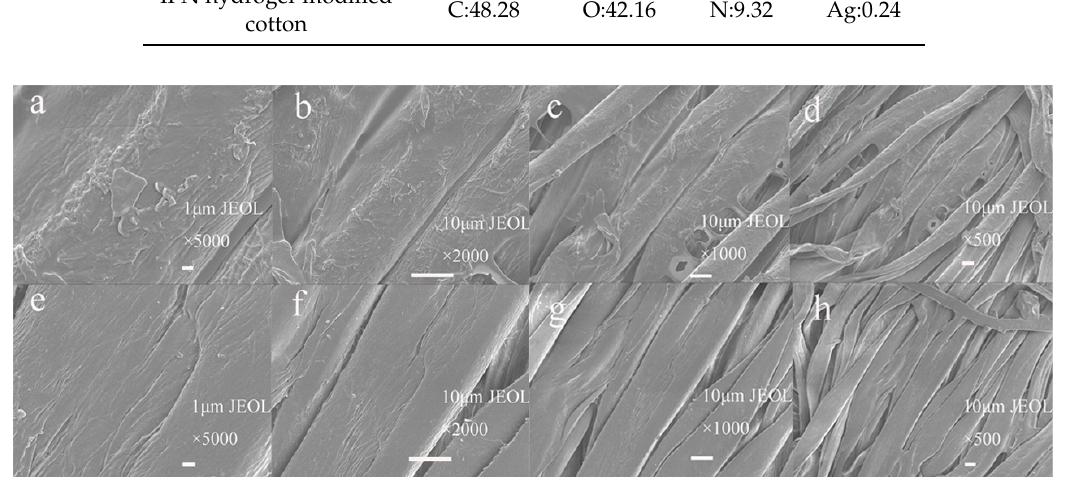
Figure 12. SEM of modified cotton ( a – d ) and unmodified cotton ( e – h ).